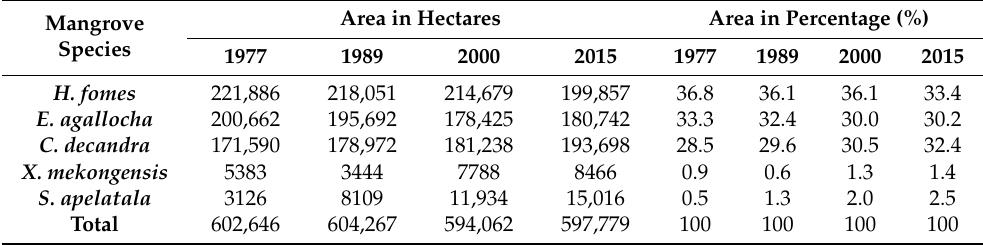
Table 2. Mangrove species composition pattern analysis of the Sundarbans (1977–2015).